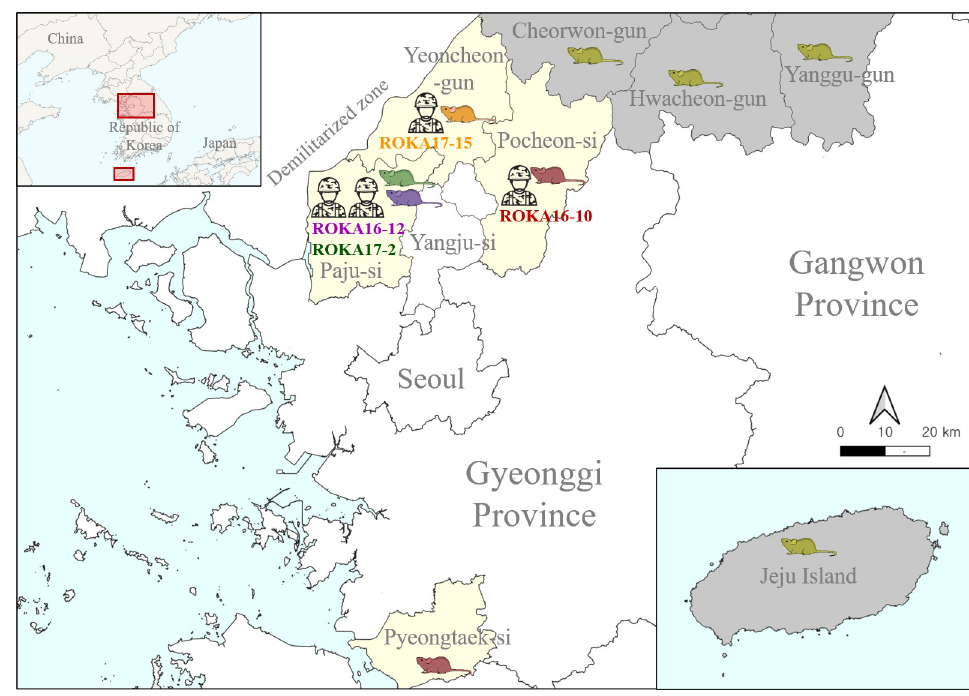
Fig 1. Geographic map of hemorrhagic fever with renal syndrome (HFRS) patients in this study. A geographic map shows the sites of patients with HFRS and rodents collected at highly endemic area in Gyeonggi and Gangwon Provinces. The red, purple, green, and orange color indicate trapped rodents which shows phylogeographic relation with each ROKA16-10, ROKA16-12, ROKA17-2, and ROKA17-15 patient, respectively. The yellow color indicates trapped rodents in Gangwon Province and Jeju Island. Paju-si, Yangju-si, Pocheon-si, Yeoncheon-gun, and Pyeongtaek-si are located in Gyeonggi Province, and Cheorwon-gun, Hwacheon-gun, and Yanggu-gun are located in Gangwon Province, Republic of Korea. We used the Quantum Geographical Information System (QGIS) software V.3.4.10. and Adobe Illustrator CS to create the geographic